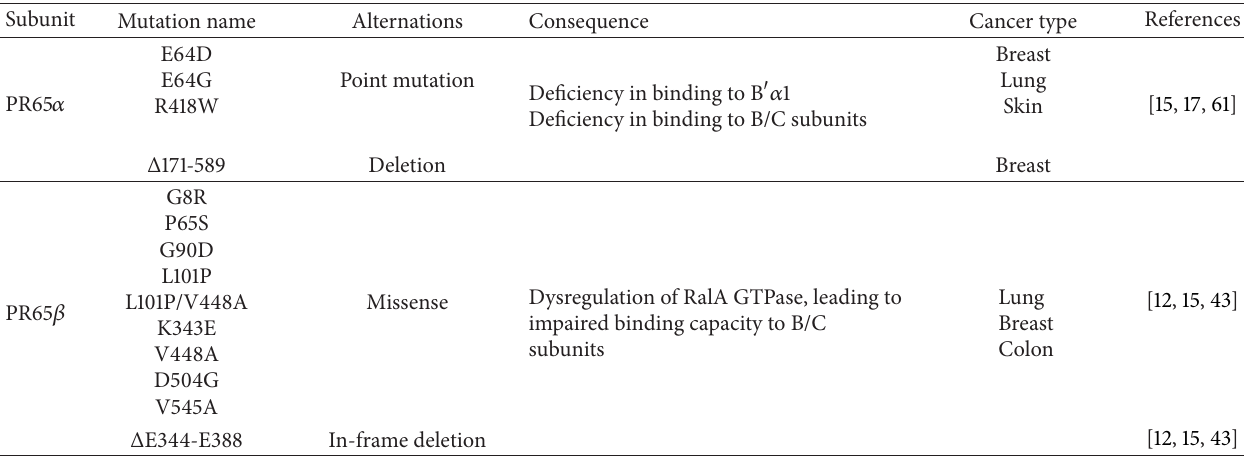
Table 2: Cancer-associated mutations of PP2A A